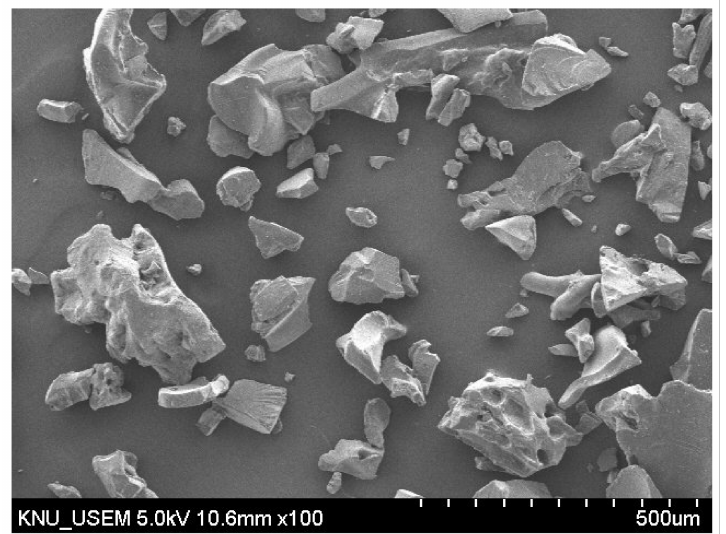
Figure 2. Scanning electron microscope (SEM) images of dried superabsorbent polymer (SAP) particles (magnification scale is